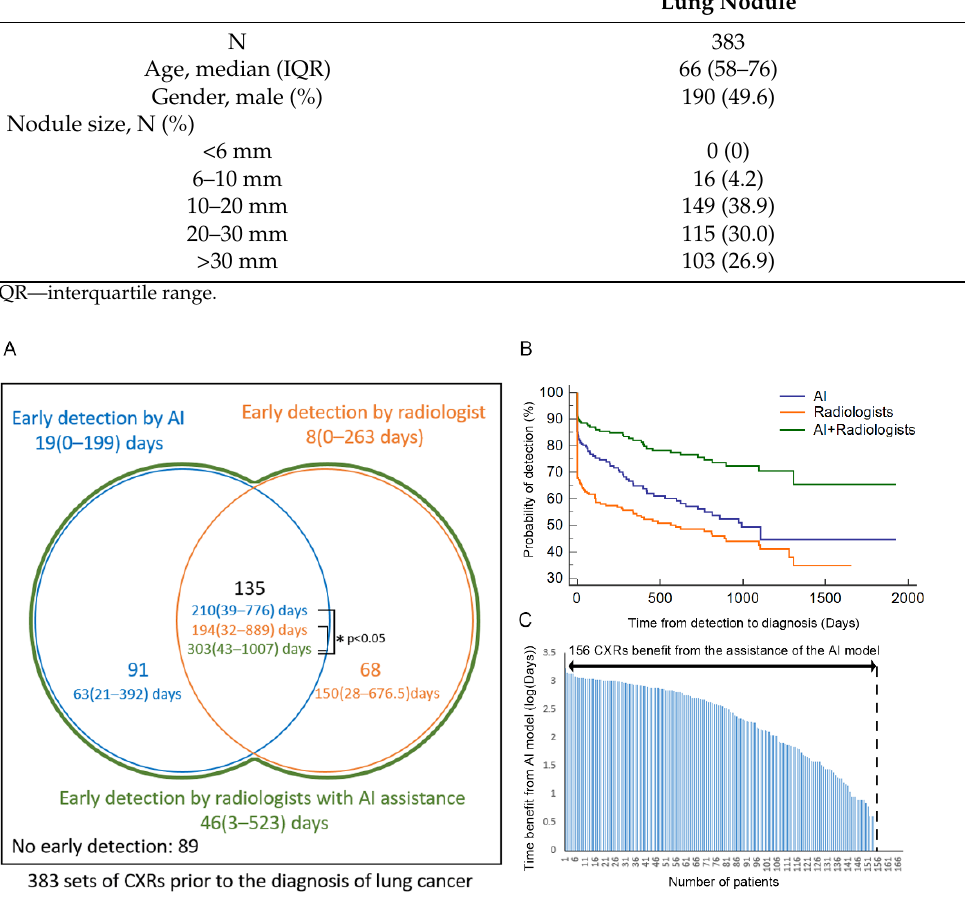
Figure 11. Performance of the radiologists, the trained AI model, and the radiologists assisted with the AI model during retrospective review of CXRs. ( A ) Comparison between the AI model (blue), radiologists (yellow), and radiologists assisted with the AI model (green). ( B ) Time from detection to diagnosis for the AI program, radiologists, and combination of the AI program and the radiologists to simulate the radiologists’ performance assisted by the AI program. ( C ) Waterfall plot of the benefit in the temporal scale of AI assistance in the retrospective review test. AI—artificial intelligence; CXR—chest X-ray.